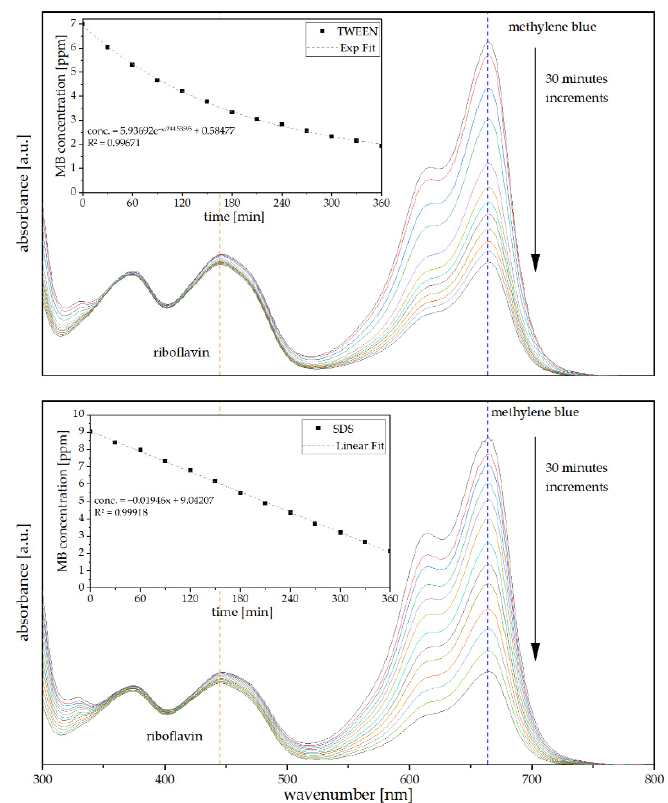
Figure 9. UV/vis spectra of a kinetic study on a MB/Riboflavin mixture over 360 min. TWEEN 10 ( top ) and SDS 4 ( bottom ) as well as fitted curves for absorption model prediction.